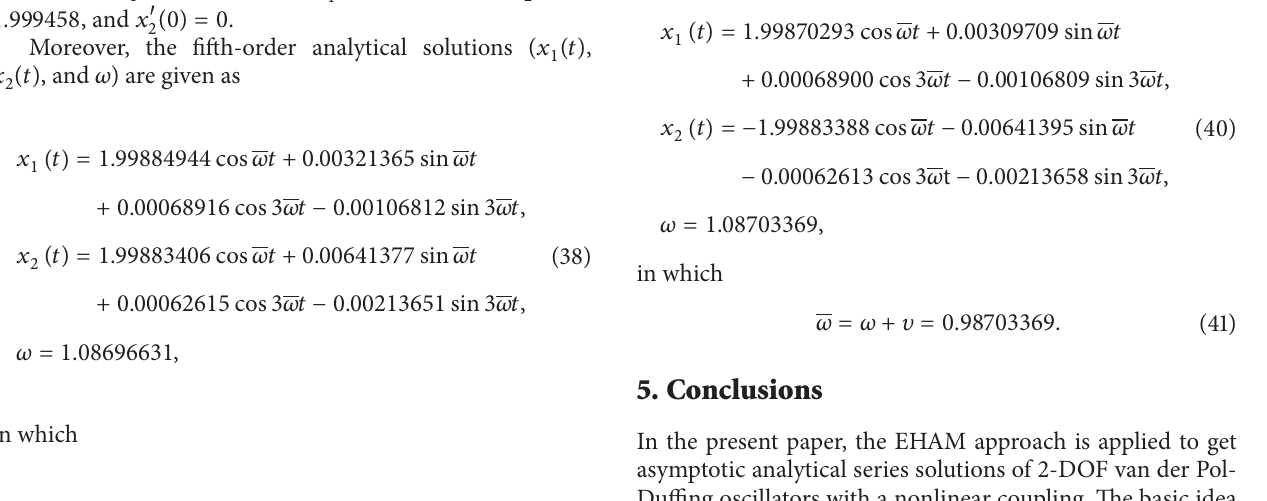
The initial conditions of the numerical integration method are 𝑥 1 (0) = 1.999538 , 𝑥 󸀠 1 (0) = 0.000037 , 𝑥 2 (0) = 1.999458 , and 𝑥 󸀠 (0) = 0 2